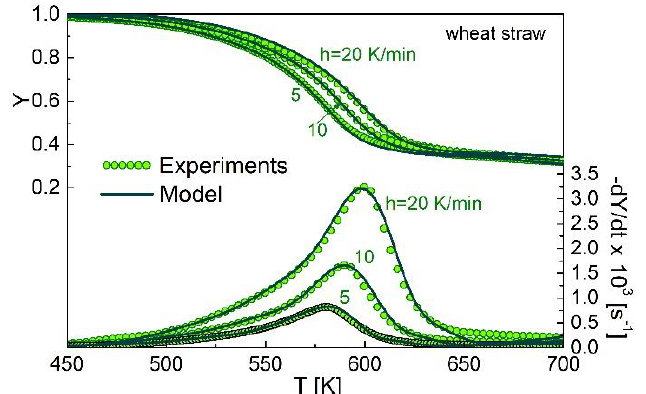
Figure 2. Comparison between predictions for wheat straw (data in Table 2A,B) (lines) and measurements (symbols) of mass fraction Y and mass loss rate − dY/dt versus temperature (heating rates 5, 10, and 20 K/min, up to 773 K).